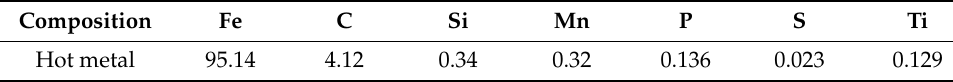
Table 5. Chemical composition of hot metal, w / w %.